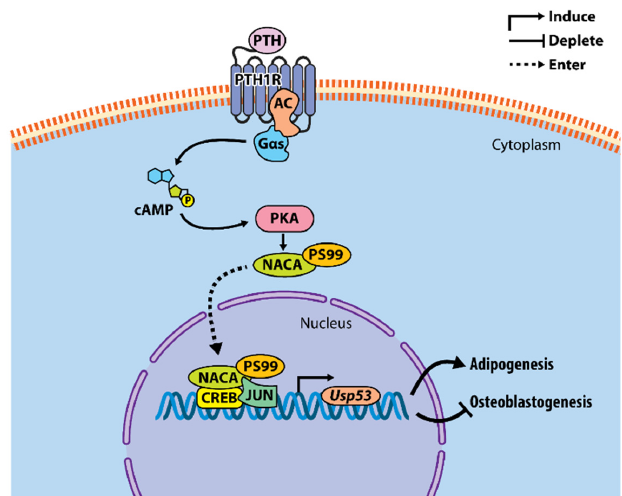
Figure 2. Model of Usp53 transcriptional regulation and its function in mesenchymal progenitors. PTH binds and activates PTH1R, inducing the coupling of PTH1R to G α s and activating adenylate cyclase (AC) to produce cAMP and activate protein kinase A (PKA). PKA phosphorylates NACA at serine residue 99 (S99) and induces its nuclear translocation. In the nucleus, NACA binds its response element in the Usp53 promoter and potentiates transcription of Usp53 with JUN/CREB in osteoblasts. Usp53 affects mesenchymal cells lineage decisions, inhibiting osteoblastogenesis and enhancing adipogenesis through mechanisms that remain to be